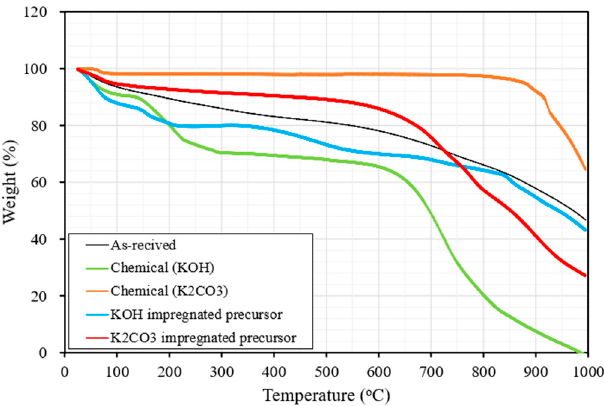
Figure 1. Thermogravimetric analysis results of chemical agents and carbon precursors impregnated with each chemical.